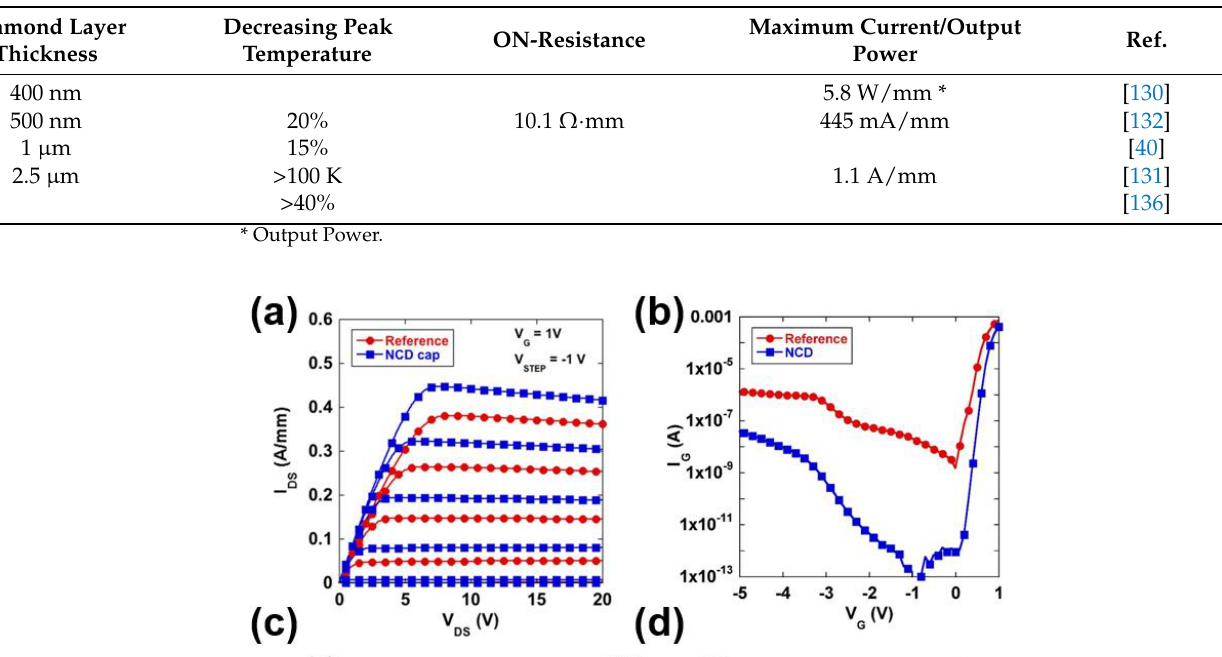
Table 5. Summary of the typical improvement in device performance.